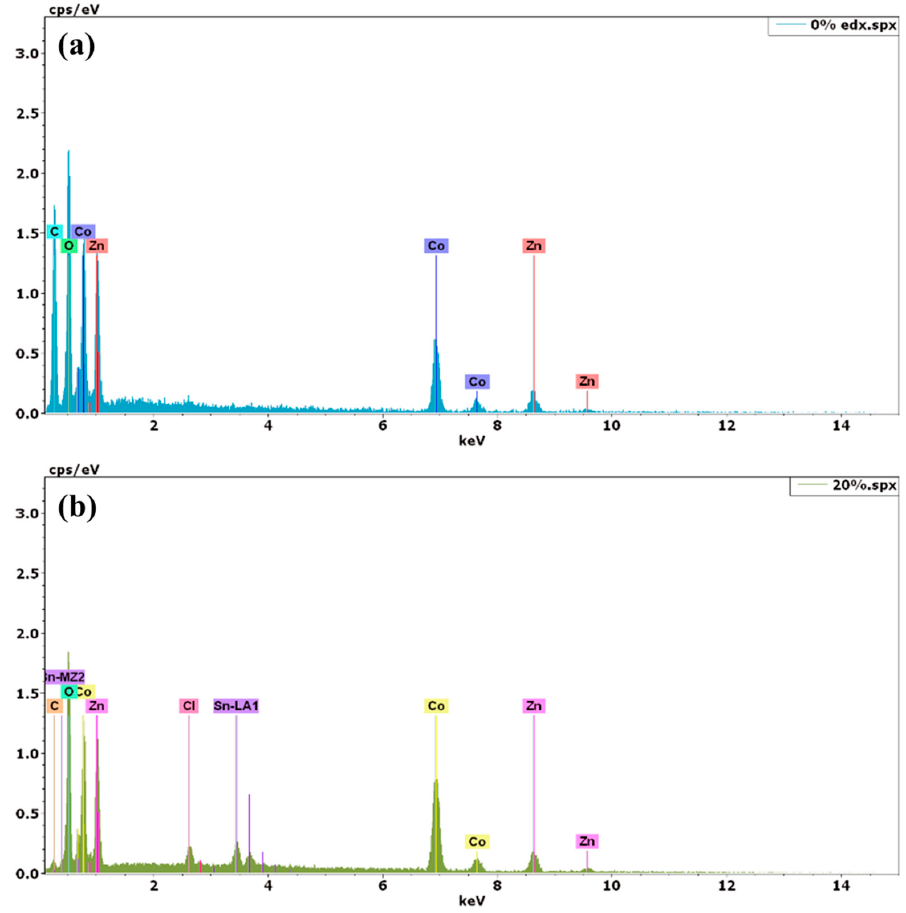
Figure 4. EDX of pure ZnCo 2 O 4 ( a ) and ZnCo 2 O 4 /SnO 2 -20% ( b ) nanoparticles.